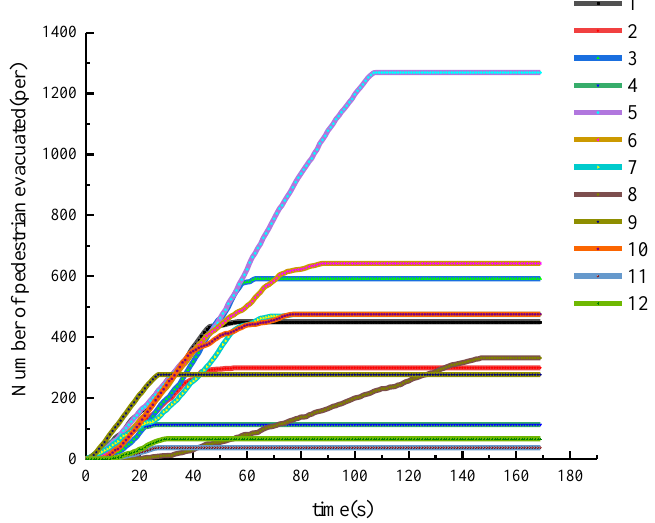
Figure 15. Number of pedestrians passing through each exit and travel time of sample 23.